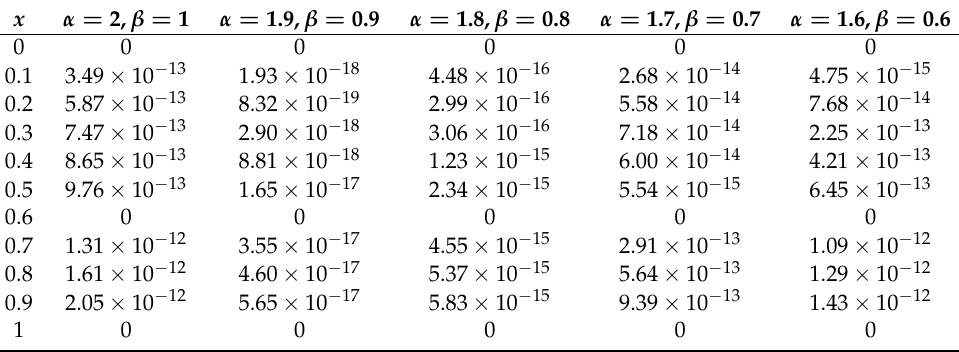
Table 5. Comparison of absolute error of Example 2 for various α , β ( m = 3, n =